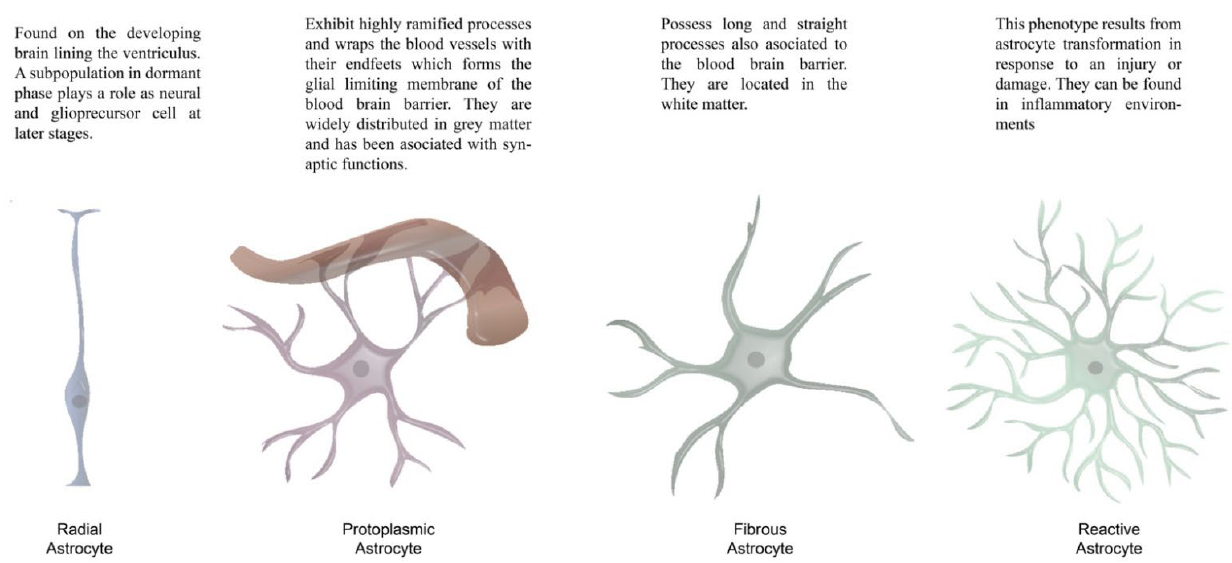
Figure 3. Illustration of the main astrocyte subtypes.